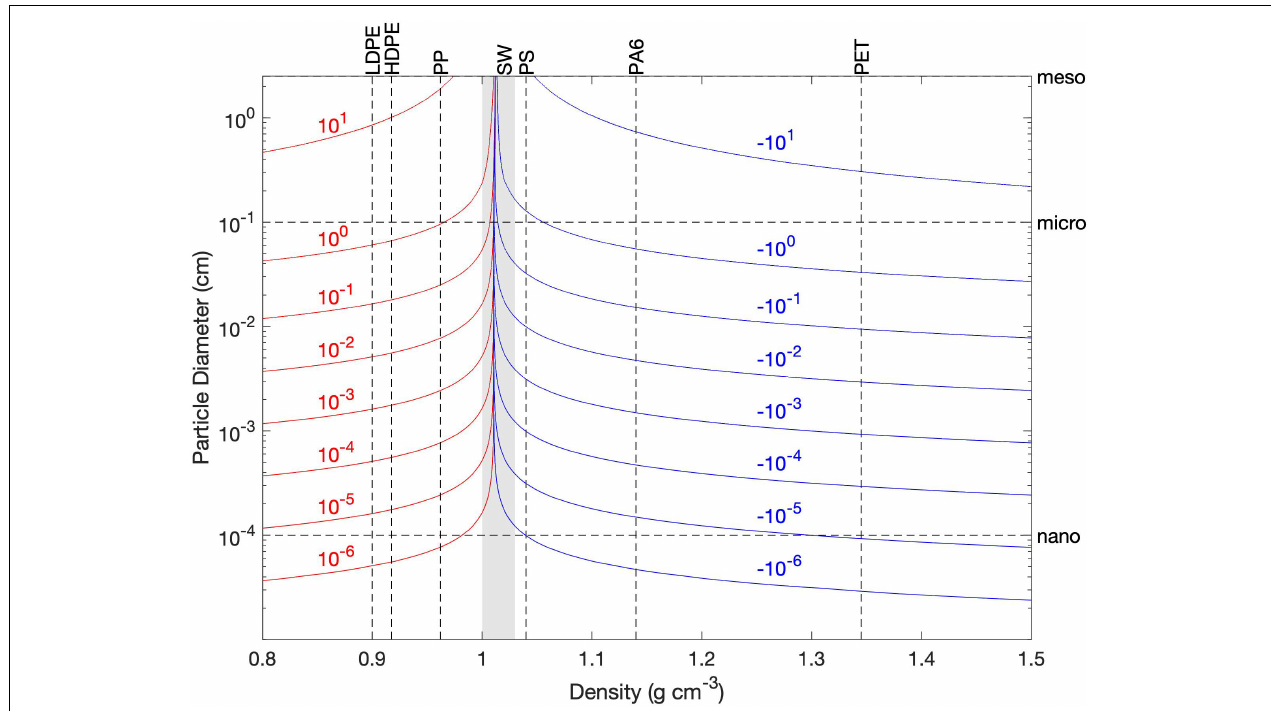
FIGURE 2 | Vertical velocity (cm s − 1 ) due to buoyancy as a function of spherical particle diameter and density, represented as contours (red for upward motion and blue for downward motion). Water density is calculated using 15 ◦ C and 15 PSU. Dashed lines indicate specific size and density values used in sensitivity testing; LDPE, HDPE, PP, PS, PA6, and PET refer to types of plastic encountered in the Chesapeake Bay (low-density polyethylene, high-density polyethylene, polypropylene, polystyrene, nylons, and polyethylene terephthalate, respectively). The shaded envelope about the line indicates the range of seawater (SW) density that occurs within the Chesapeake Bay based on a temperature range of 0–30 ◦ C and a salinity range of 0–30